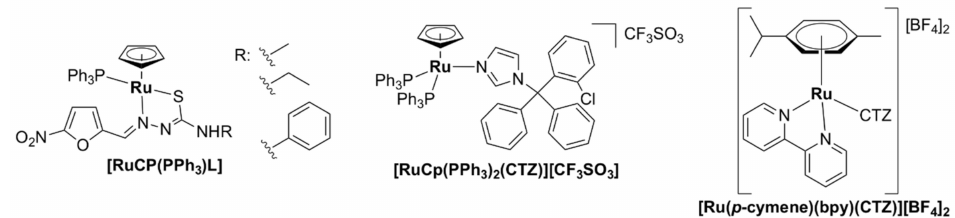
Figure 27. Chemical structures of Ru(II)–arene complexes with antitrypanosomal